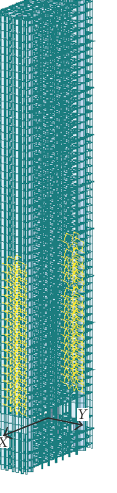
Figure 12: FEM with the viscous dampers implemented in the cores.